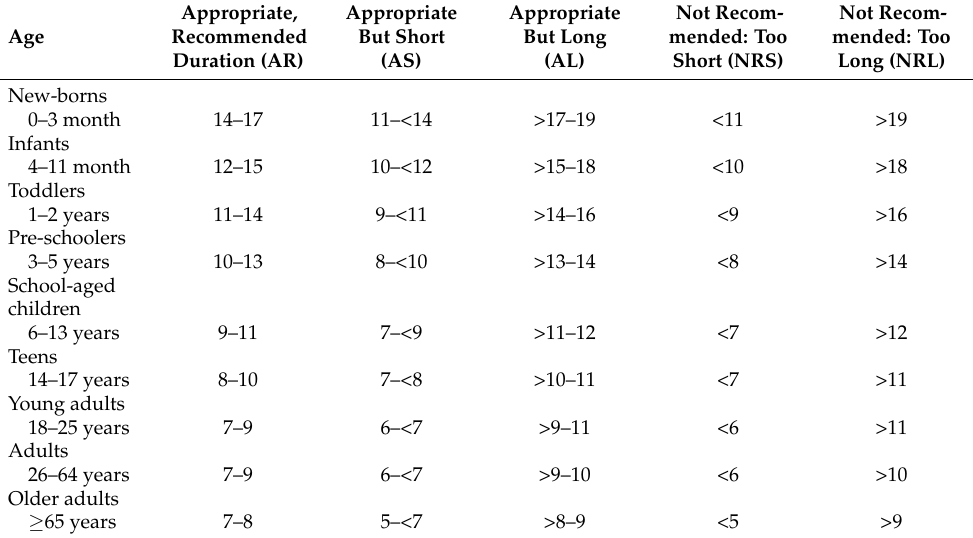
Table 1. The National Sleep Foundation’s age-specific guidelines for sleep duration in hours